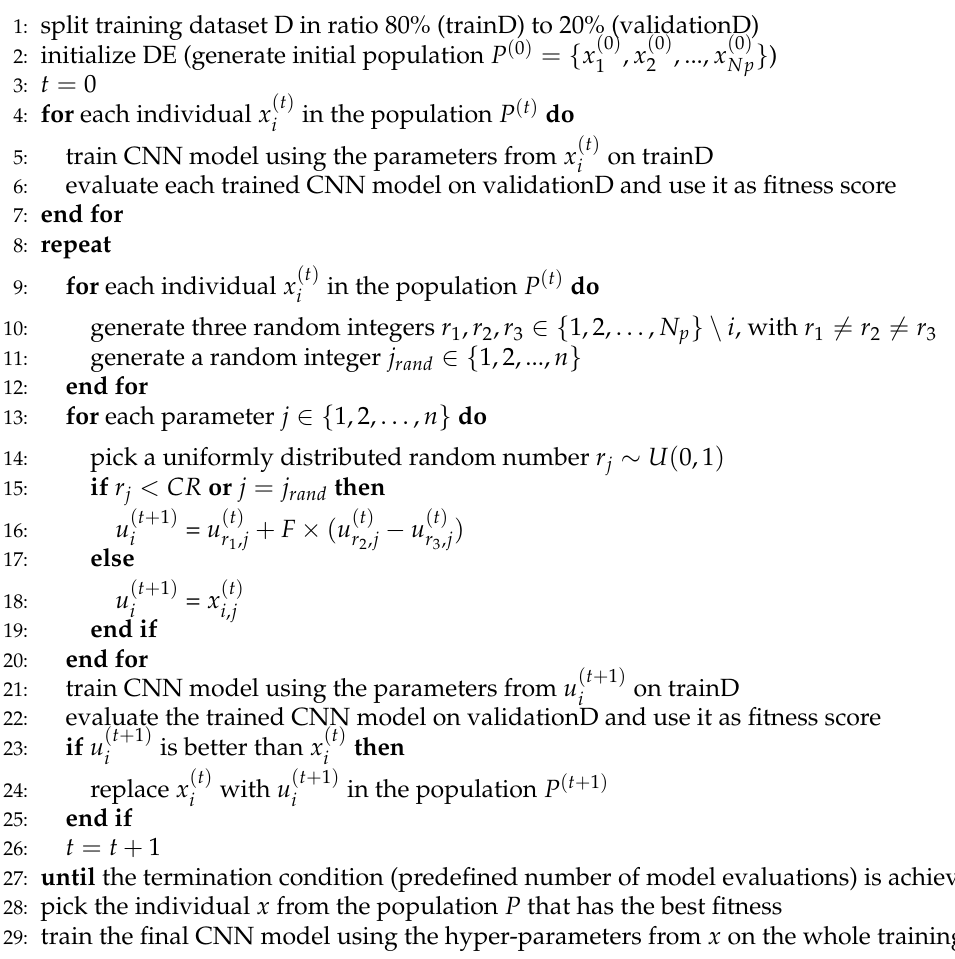
Algorithm 1 CNN-TL-DE